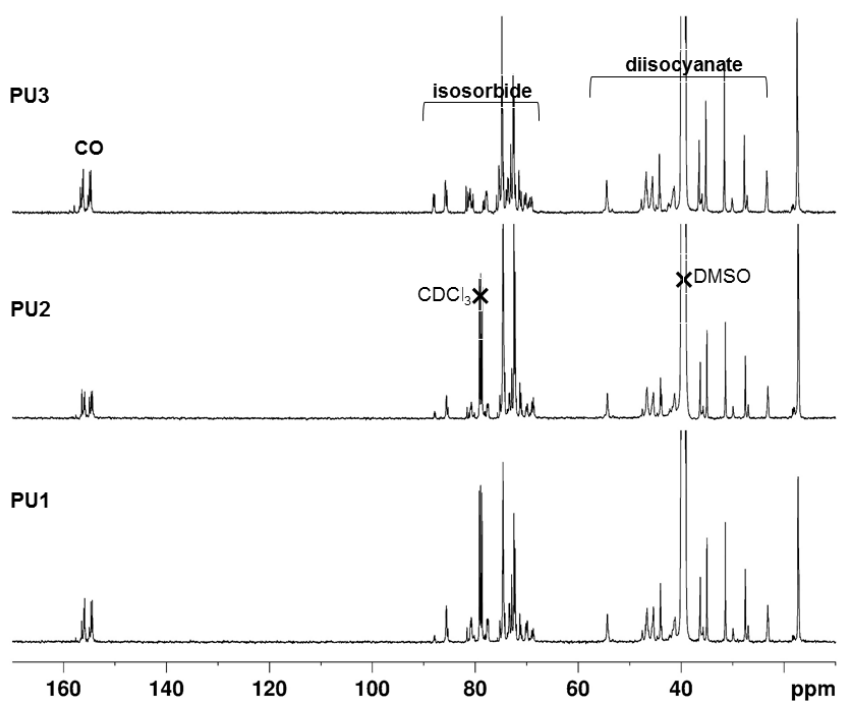
Figure 8. The 13 C{ 1 H} NMR spectra of PU1 , PU2 , and PU3 in DMSO- d 6 . Traces of CDCl 3 are seen in the spectra of PU1 and PU2 .